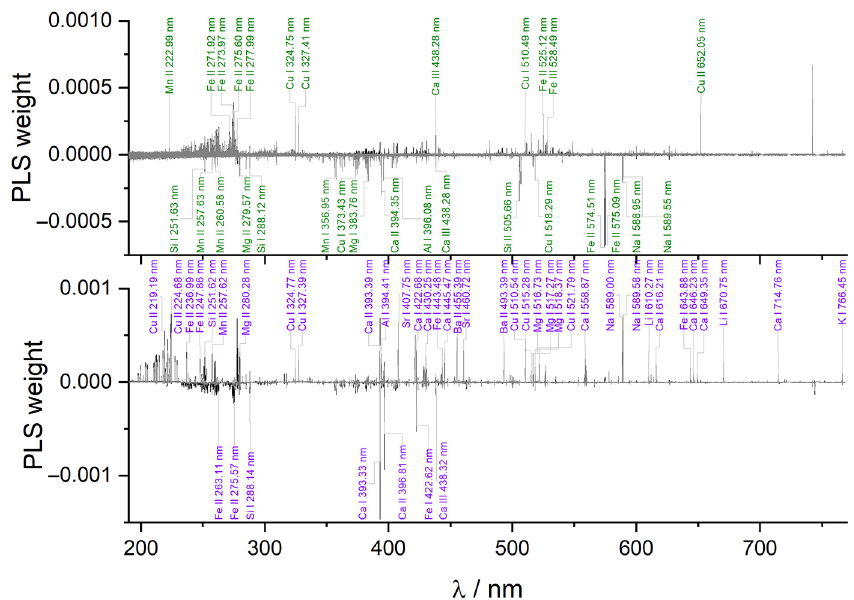
Figure 6. Weighting of PLSR as a function of wavelength for PLSR of field samples from Cyprus ( top , green) and Poland ( bottom , purple) with 2 components each (first component black, second component grey).